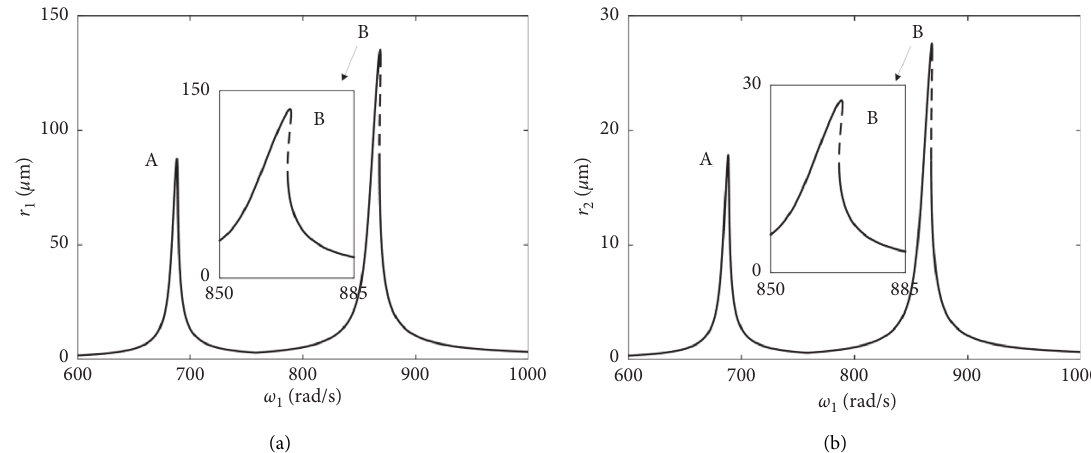
Figure 6: Amplitude frequency curves for the bifurcation mode of the region II in Figure 4 ( k the LP rotor. (b) For the HP rotor. Solid lines represent stable solutions, and dotted lines represent unstable solutions.